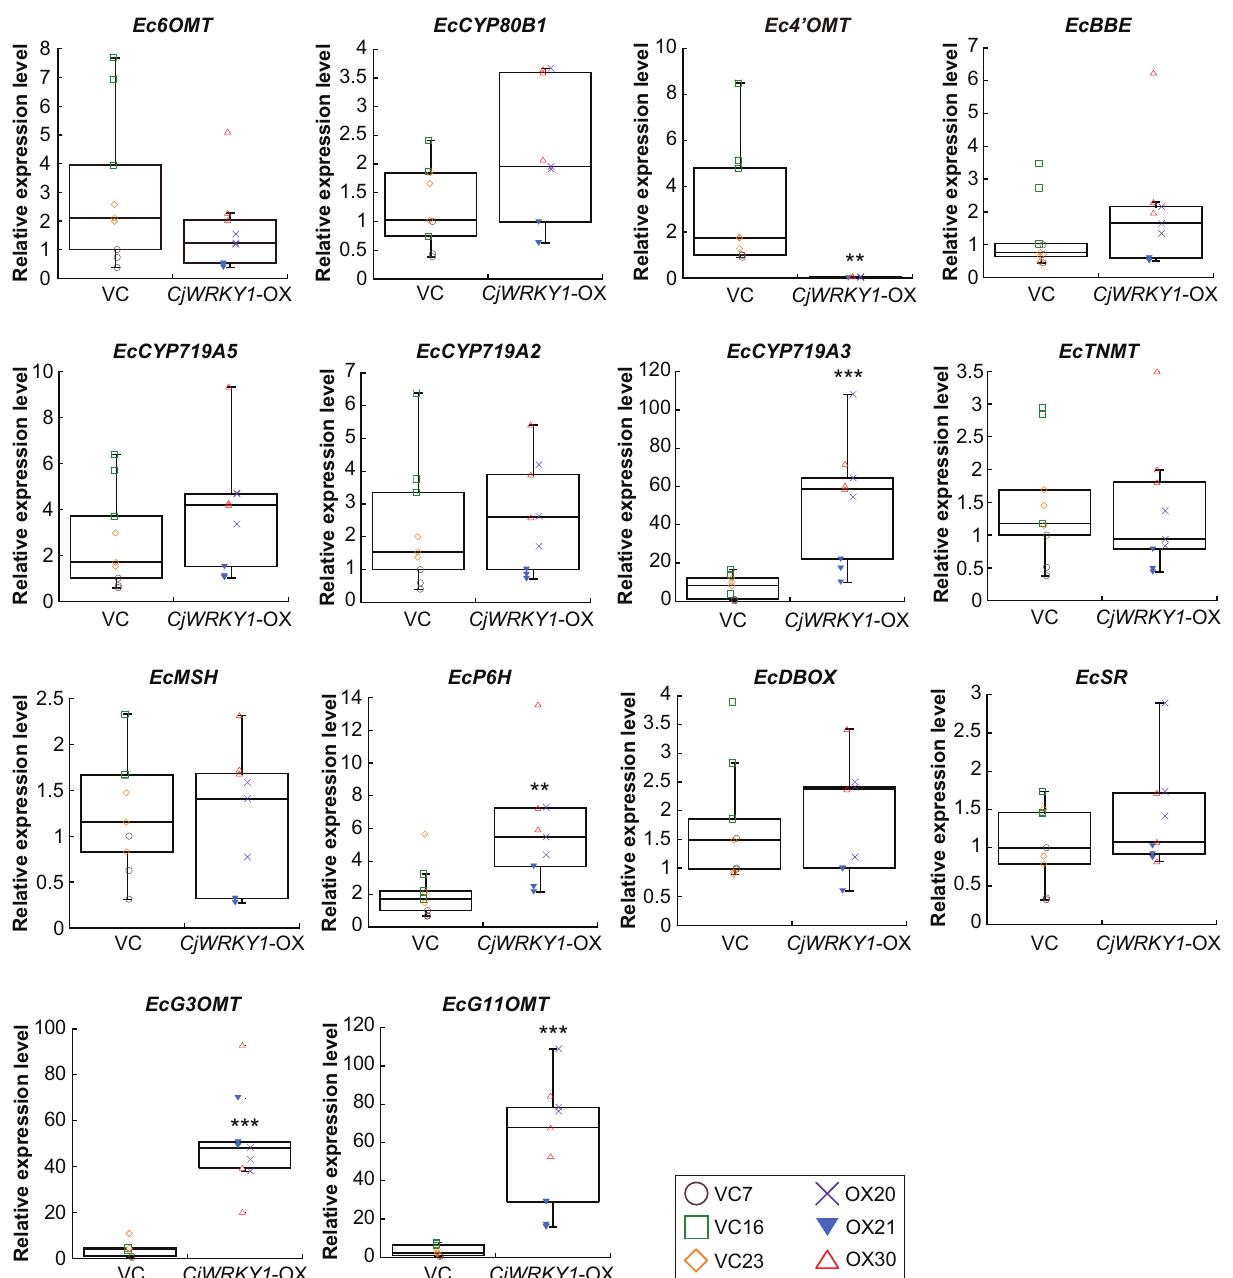
Fig 3. Effects of CjWRKY1 -overexpression on genes encoding BIA biosynthetic enzymesin transgenic California poppy cell lines. The transcript levels of Ec6OMT , EcCYP80B1 , Ec4’OMT , EcBBE , EcCYP719A5 , EcCYP719A2 , EcCYP719A3 , EcTNMT , EcMSH , EcP6H , EcDBOX , EcSR , EcG3OMT , and EcG11OMT were determinedby quantitativeRT-PCR. Nine biologicalreplicates were used of each cell line. Asterisks indicatea significantdifference comparedwith VC cell lines ( * P < 0.05, ** P < 0.01, *** P < 0.001; two-tailed pairedStudent’s t -